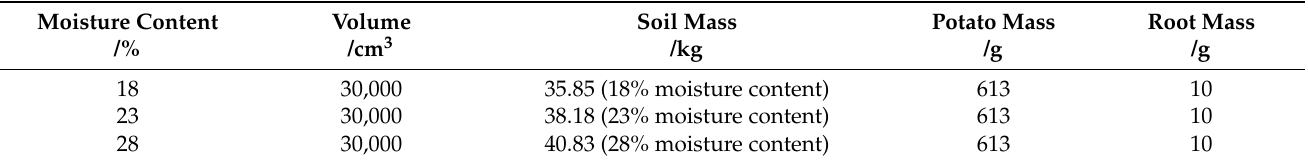
Table 1. Masses of the individual constituents of samples with different initial moisture